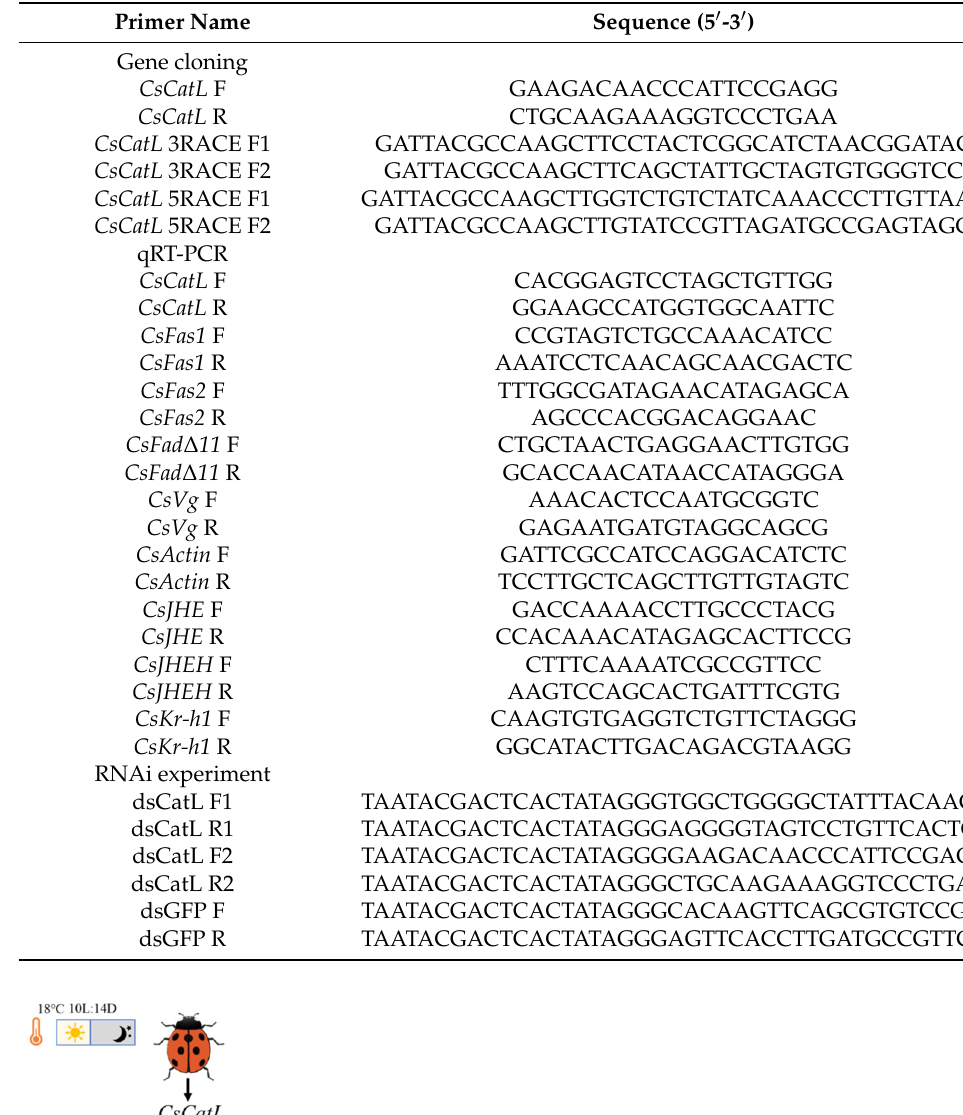
Table 1. The primers used in this study.